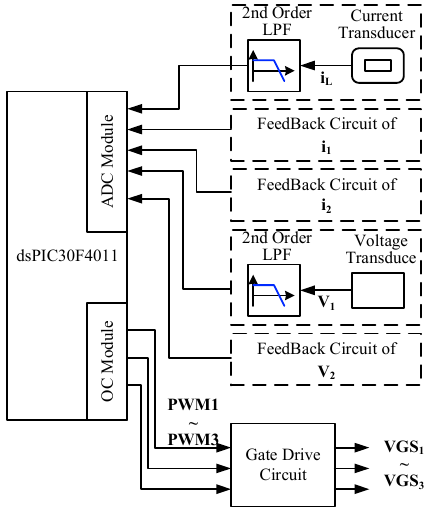
Figure 14. Schematic diagram of the controller.